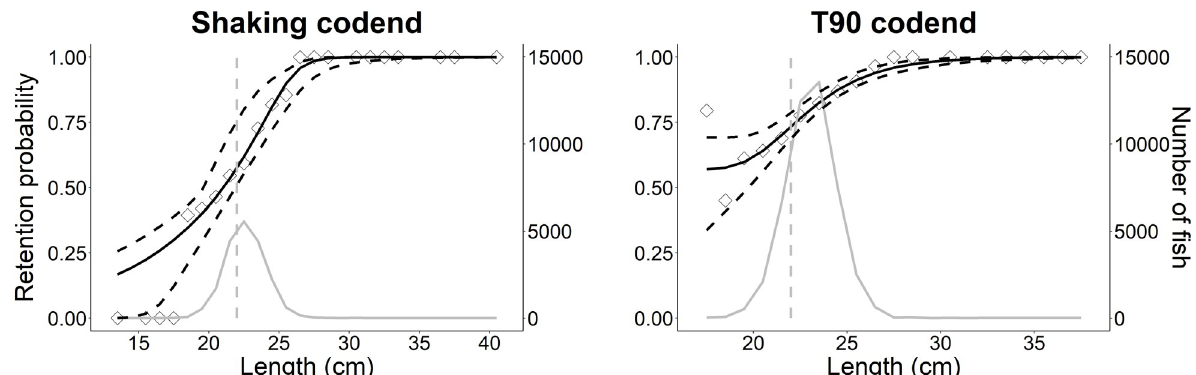
Fig 6. Size selectivity plots for the shaking and T90 codends. The black line represents the size selectivity curves. The vertical grey dashed lines represent the minimum landing size (MLS) for the Canadian redfish fishery. Diamonds correspond to the experimental ratios, whereas grey lines represent the size distribution of the redfish population captured during testing. Dashed black lines are the 95% Efron percentile confidence intervals.